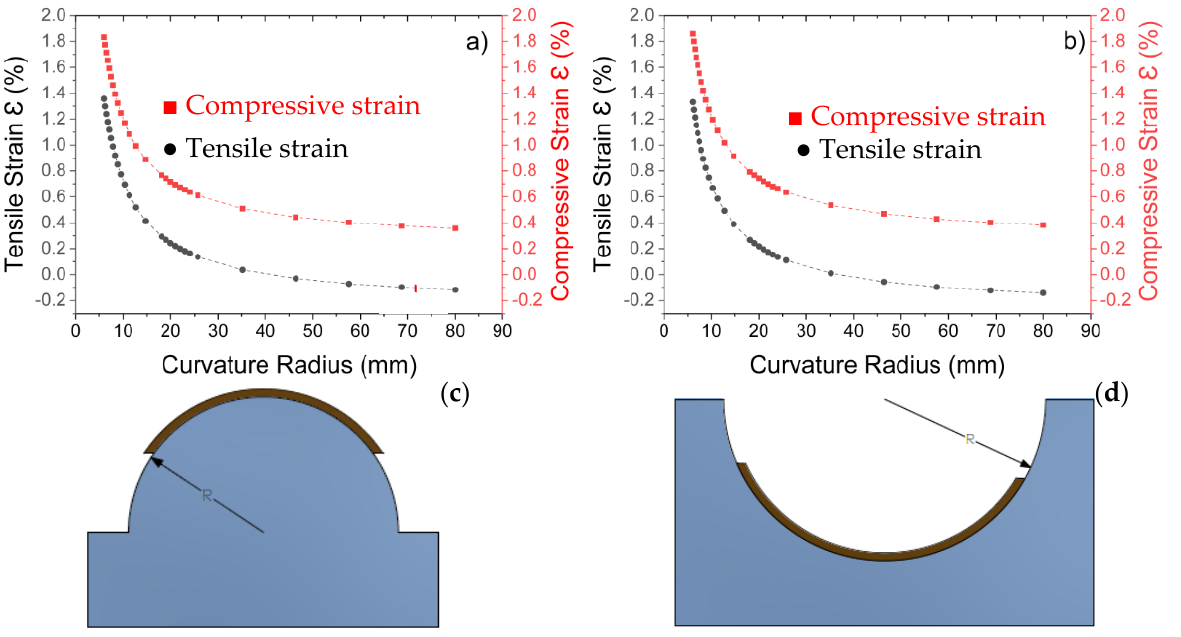
Figure 1. Total positive (tensile) and negative (compressive) mechanical strain vs. radius of curvature for ( a ) n-type and ( b ) p-type µc-Si: H thin film calculated using equation (2), and schematic for the tensile ( c ) and compressive ( d ) bending direction.